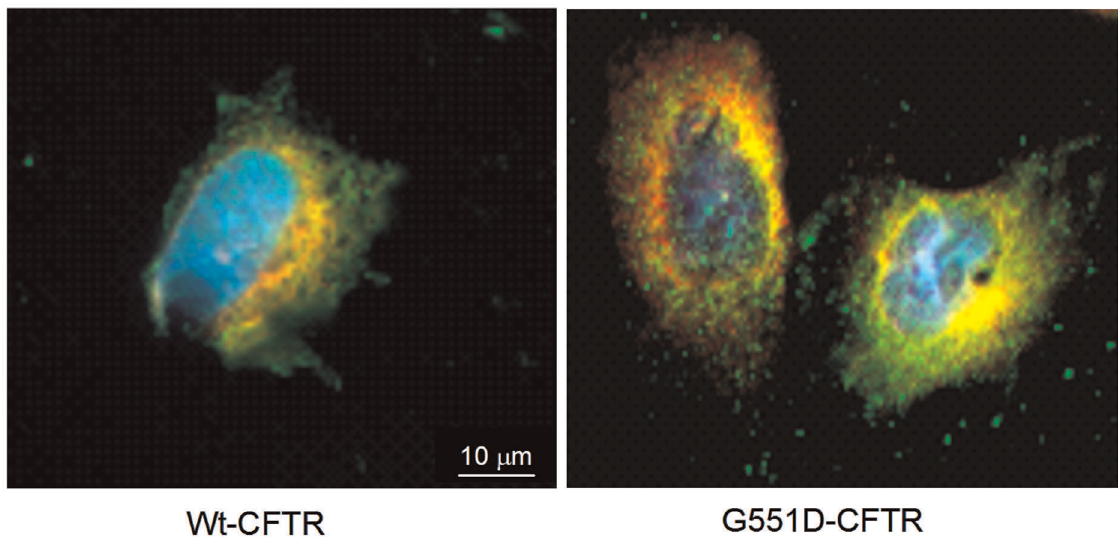
Figure 6. The calumenin – CFTR interaction takes place in the ER. Immunofluorescent localization of Calumenin within Wt- (left) and G551D- CFTR (right) expressing cells. The nuclei were labelled in blue by DAPI. The ER was visualized using PDI labelling (red) and Calumenin was seen in green. Overlapping of PDI and Calumenin is yellow showing the described interaction between Calu and CFTR takes place within the ER.